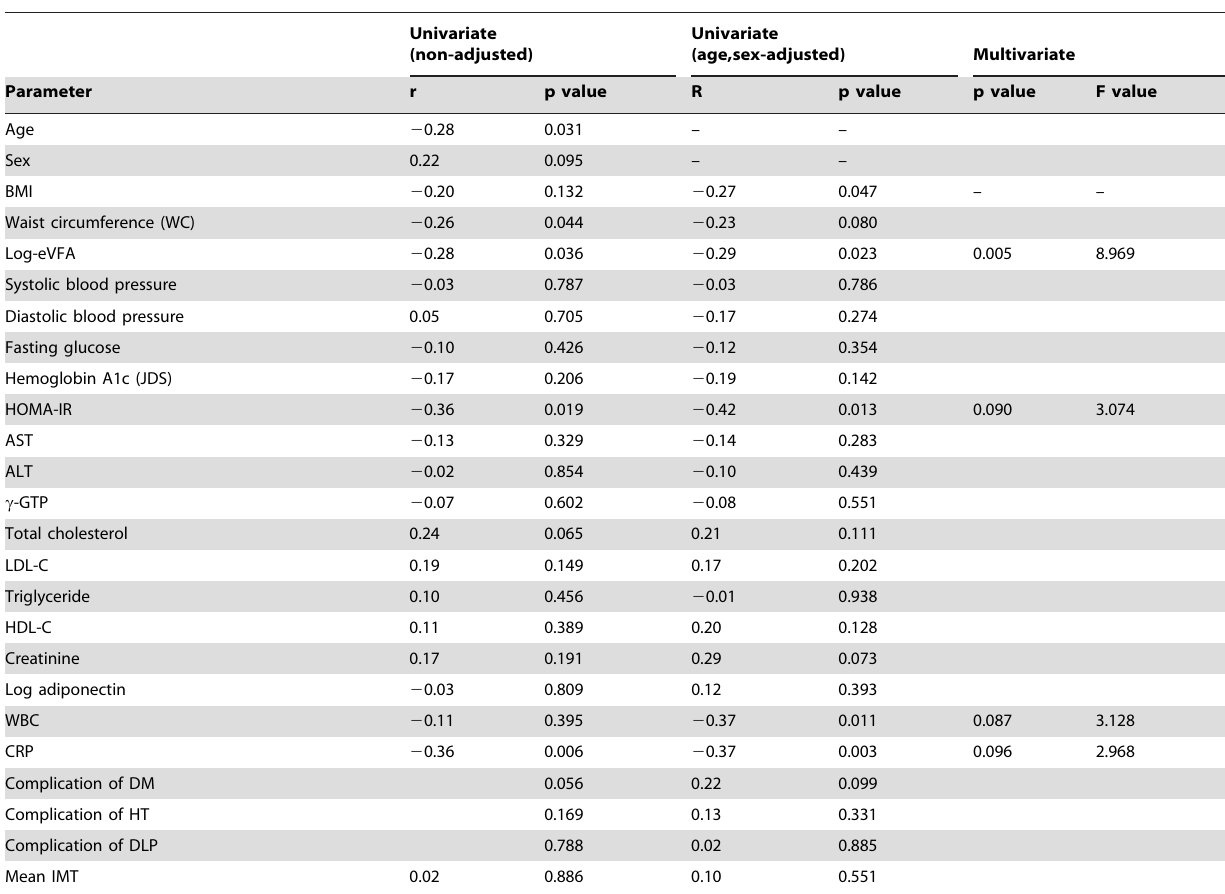
Table 4. Correlation between PER1 and metabolic